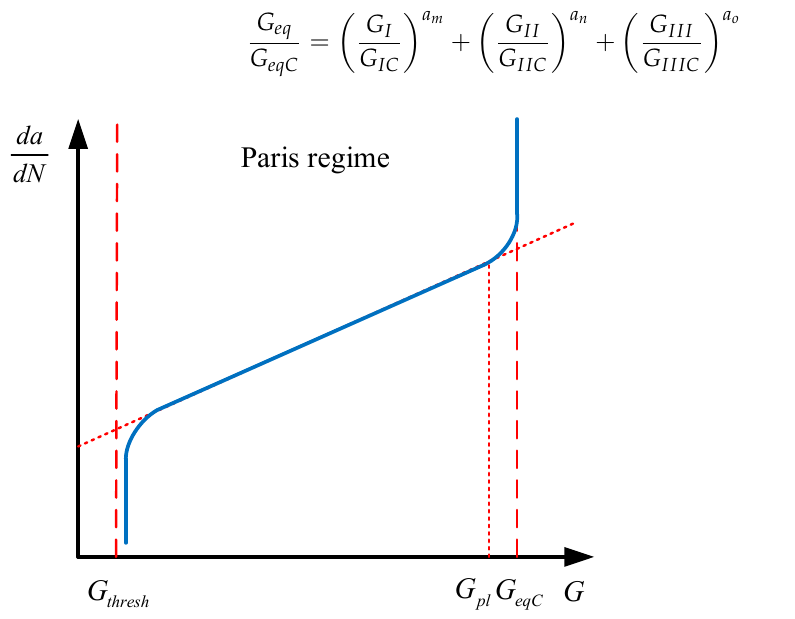
Table 2. Material constants in Paris’ law and Abaqus.